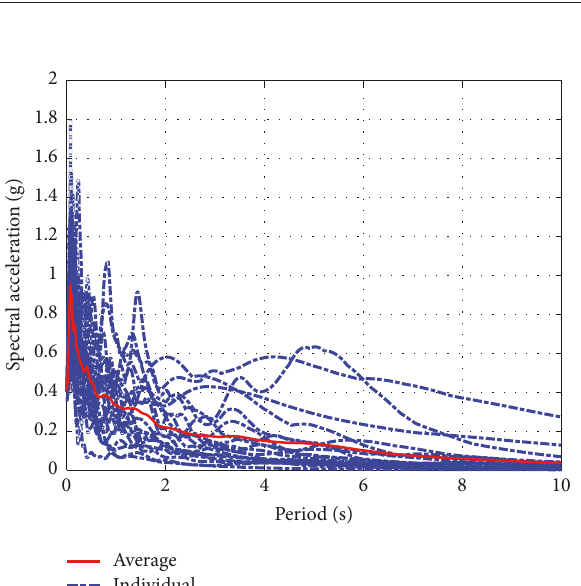
Figure 5: Elastic earthquake acceleration response spectra for 5% critical damping.